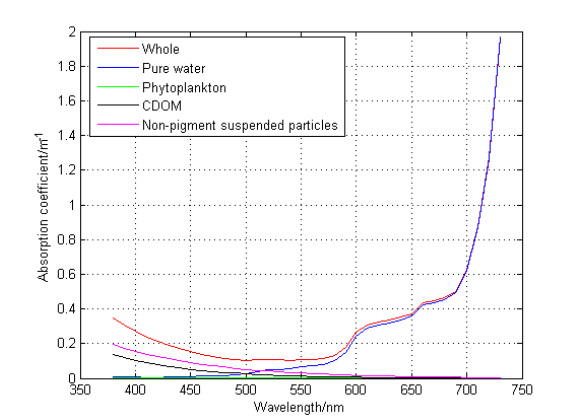
Figure 1. Absorption spectra of seawater